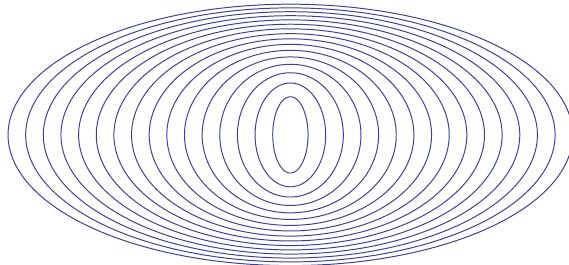
Fig. 1. Vertical cut of the average eddies -more precisely: average iso-contours of the horizontal velocity fluctuations- of a turbulence in a space of (fractal) dimension D = 2 + H z (0 ≤ H z ≤ 1) (here with the theoretical value H z = 5 / 9, see text). The largest structures are flattened along the horizontal in agreement with the layered pan- cake structure, which is typical of rotating and stratified turbulence, but remain distinct from 2-D structures.This flattening is more pro- nounced for lower and lower values of H z